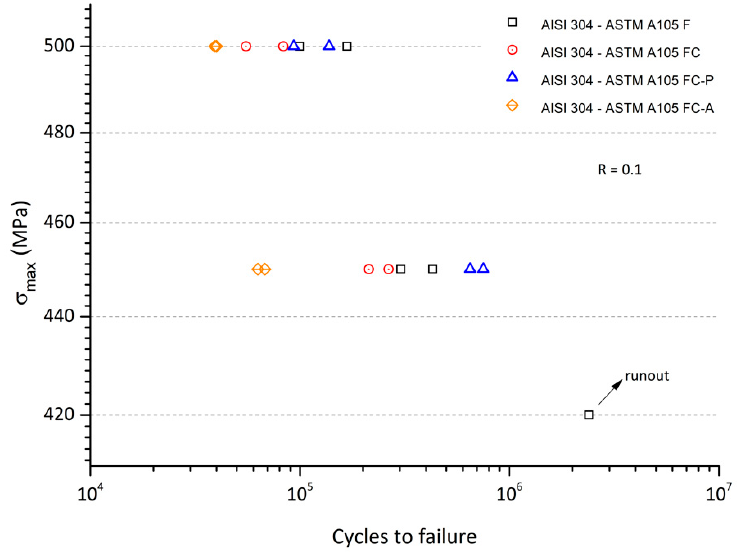
Figure 7. S-N curves for AISI304—ASTM A105 welded specimens under different testing conditions.